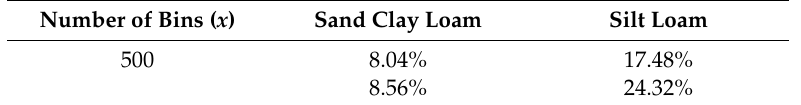
Table 4. Influence of large number of bins on the infiltration rate compared with 100 bins as the baseline.